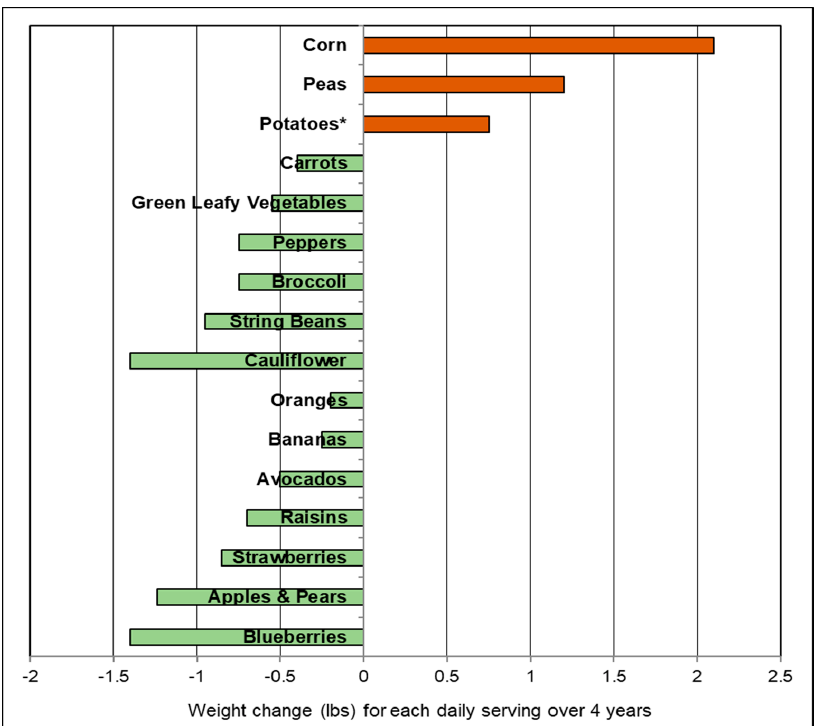
Figure 4. Associations between a daily serving of specific non-juice fruits and vegetables and weight change in US men and women over 4 years from the Nurses’ Health Studies and Health Professionals Follow-up Study (pooled data; multivariate adjusted; *excludes French fries and potato chips) [96]. Nutrients 2018 , 10 , x FOR PEER REVIEW